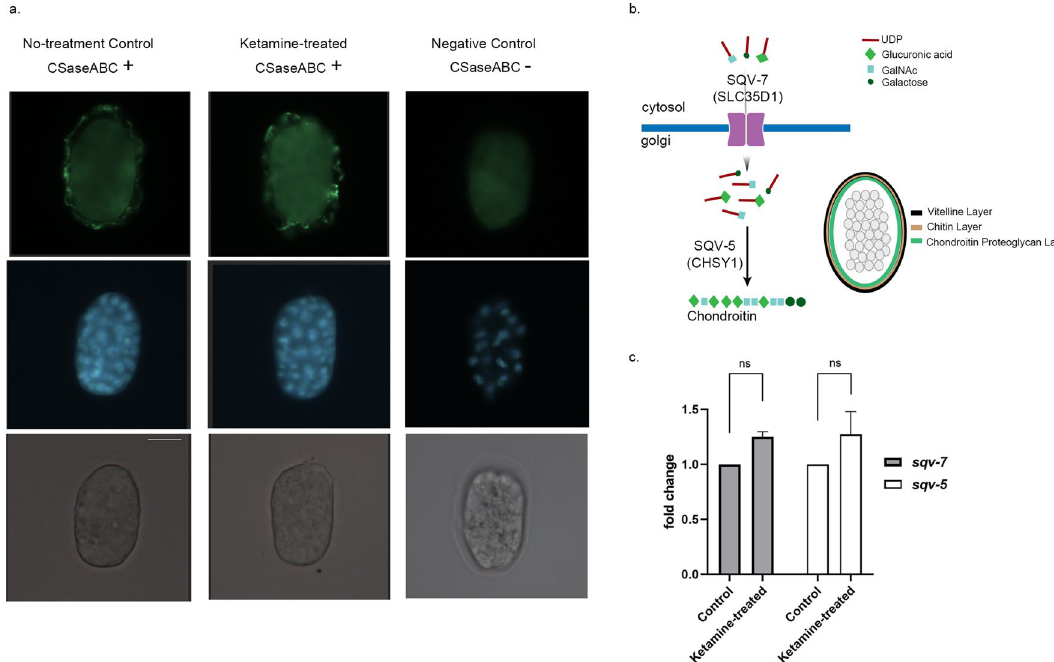
Figure 6. Ketamine-treated animals show wild type-like chondroitin phenotypes ( a ) Control and ketamine- treated embryos stained with anti-chondroitin antibody (anti-proteoglycan ΔDi-0S antibody 1B5) are shown in the top panel. Chondroitinase ABC (CSase ABC) enzyme was used for no-treatment and ketamine- treated embryos. As per negative control no enzyme was used. Middle panel shows the nuclei of the embryo stained with DAPI and the bottom panel shows DIC. Scale bar 25 μm ( b ) The organization of the eggshell is depicted. Chondroitin proteoglycan layer resides beneath the vitelline and chitin layers. The biosynthesis of the chondroitin chains is illustrated with a focus on two key regulatory proteins, UDP-sugar transporter SQV-7 and chondroitin synthase SQV-5 with mammalian homologs of SLC35D1 and CHSY1, respectively. ( c ) Relative sqv- 5 and sqv-7 expression levels in control and ketamine-treated animals were measured using real time RT-PCR. Data shown are derived from three biological replicates (Two-way ANOVA with Šídák’s multiple comparisons test, mean ± sem, p = 0.3032 for sqv-7 and p = 0.2588 for sqv-5 , ns: not